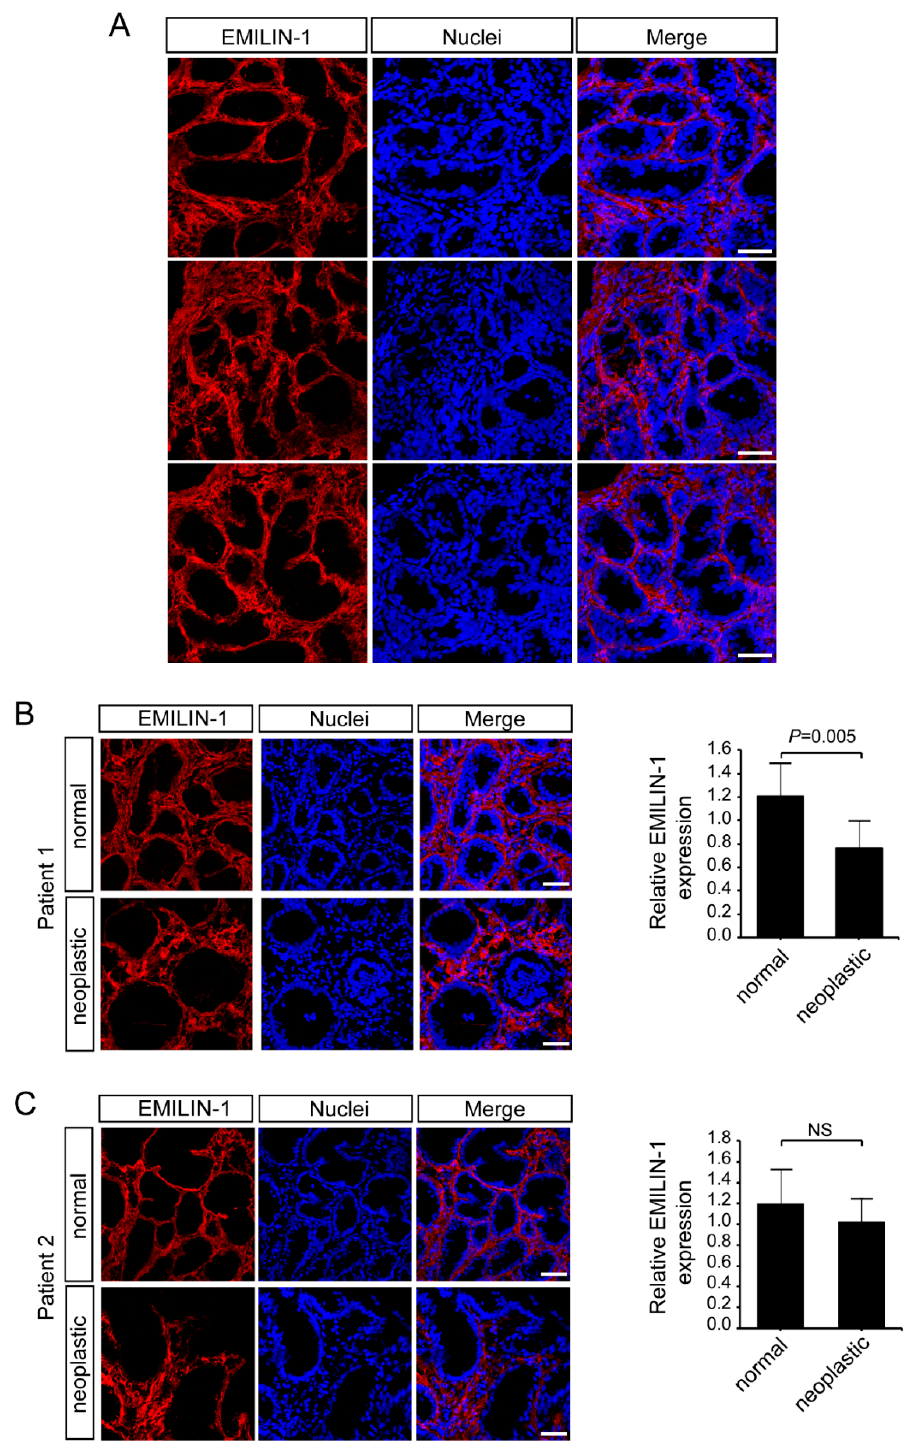
Figure 4. EMILIN-1 deposition is altered in a number of gastric cancer patients. ( A ) Representative images of normal gastric mucosa samples stained with anti-EMILIN-1 (red). Nuclei were stained with TO-PRO ® 3 (blue). Scale bar = 50 μ m. ( B ) Representative images and quantification of the expression of EMILIN-1 (red) in normal and gastric cancer samples from Patient 1. Nuclei were stained with TO-PRO ® 3 (blue). Scale bar = 50 μ m. ( C ) Representative images and quantification of the expression of EMILIN-1 (red) in normal and gastric cancer samples from Patient 2. Nuclei were stained with TO-PRO ® 3 (blue). Scale bar = 50 μ m. Graphs represent the mean ± SD; p values were obtained using the paired Student’s t -test.